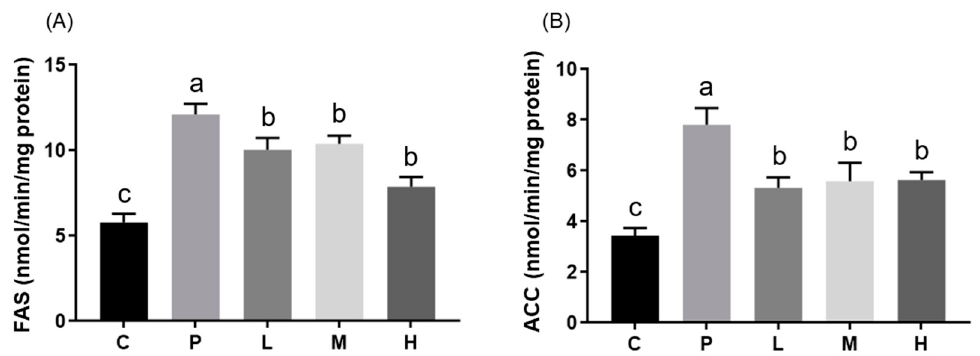
Figure 5. Hepatic lipogenic enzyme ( A ) ACC and ( B ) FAS activities in hamsters fed a HFD after a melatonin intervention for eight weeks. Daily gavage administration of melatonin at 10 (L), 20 (M), or 50 (H) mg/kg, or the ethanol vehicle to hamsters fed an HFD (P) or control diet (C). All values are the mean ± SEM ( n = 6–8). Different letters (a, b, c) indicate a significant difference at p < 0.05 determined using two-way